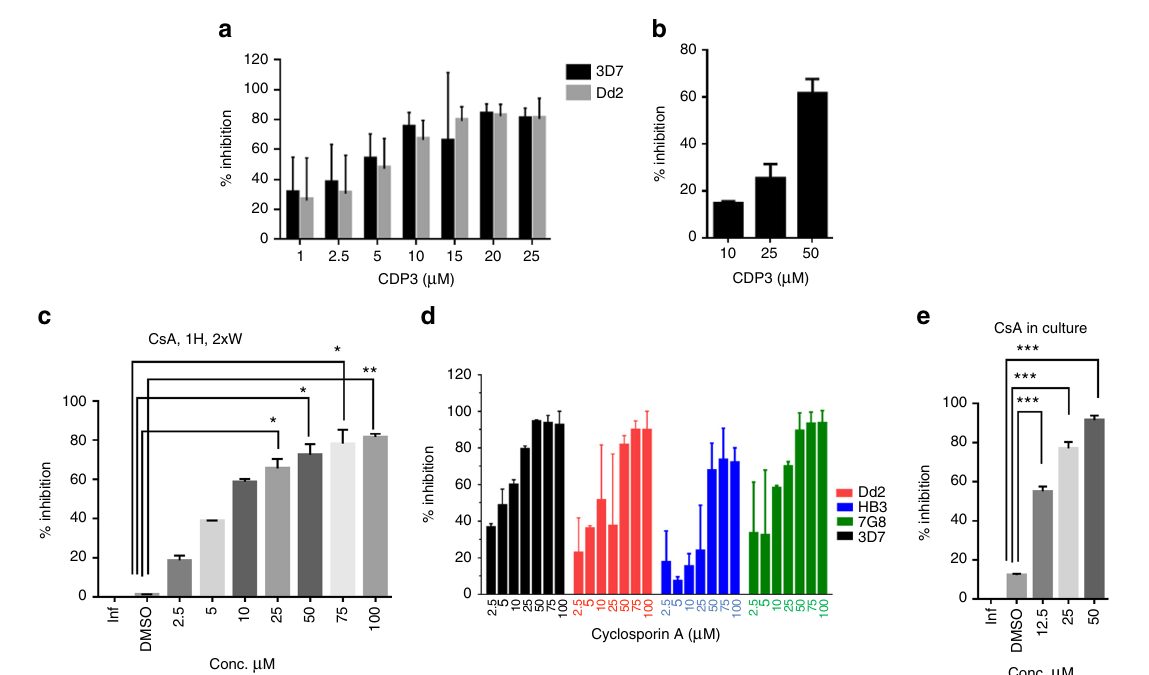
Fig. 6 Treatment of human RBCs with CDP3 and Cyclosporin A (CsA) suggests Cyclophilin B plays a crucial role in P. falciparum invasion of host RBCs. Invasion Assay using CDP3: a Invasion inhibition of P. falciparum strains 3D7 and Dd2 by CDP3 into culture. Puri fi ed recombinant CDP3 protein (1 – 25 µ M) was added to mature schizont stage parasite culture and the parasitaemia estimated after 40 h using fl ow cytometry. The data represent an average of three independent experiments each performed in duplicate. Invasion observed in control culture was taken as 100%. The CDP3 buffer components did not affect parasite invasion. b Similarly, Uninfected RBCs were treated with CDP3 (10, 25, 50 µ M) for 4 h at RT followed by 3D7 merozoites infection. Parasitemia was analyzed using FACS. c − e Dose dependent inhibition of invasion by CsA treatment of RBC: Uninfected BCs treated with CsA (2.5 – 100 µ M) followed by 3D7 merozoites infection. Invasion was reduced by ~80%. Similar results were obtained by using different strains of P. falciparum including Dd2, HB3 and 7G8. CsA (12.5 – 50 µ M) added in culture at late schizont stage; parasitemia was estimated after 40 h. 80 – 90% inhibition of invasion was observed. Statistical signi fi cance was determined using the unpaired t -test with Welch ’ s correction. ** P < 0.01 was considered signi fi cant. Each bar represents the mean ± S.D. for three independent biological